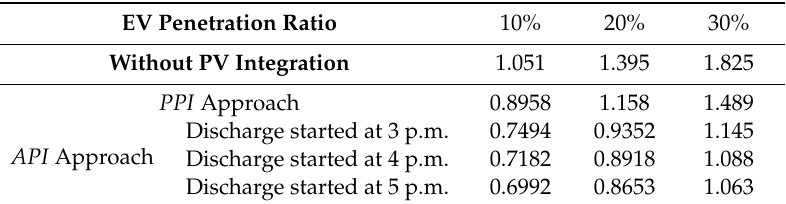
Table 1. Comparison of DT LOL (10 − 4 %) for a 24 h period.